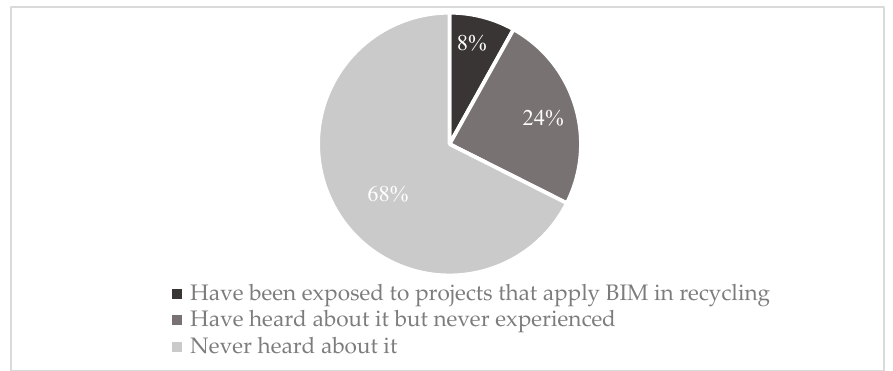
Figure 7. Respondents’ familiarity with applying BIM in recycling.